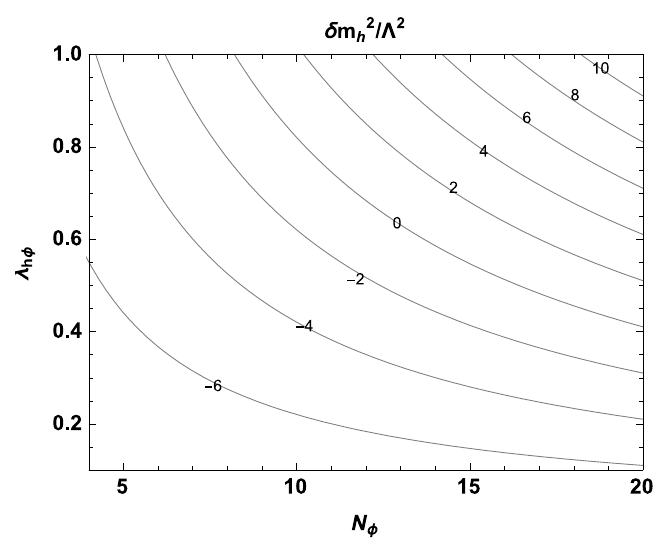
Figure 10 . The quadratic corrections in the parameter space of N (cid:30) and (cid:21) h(cid:30)